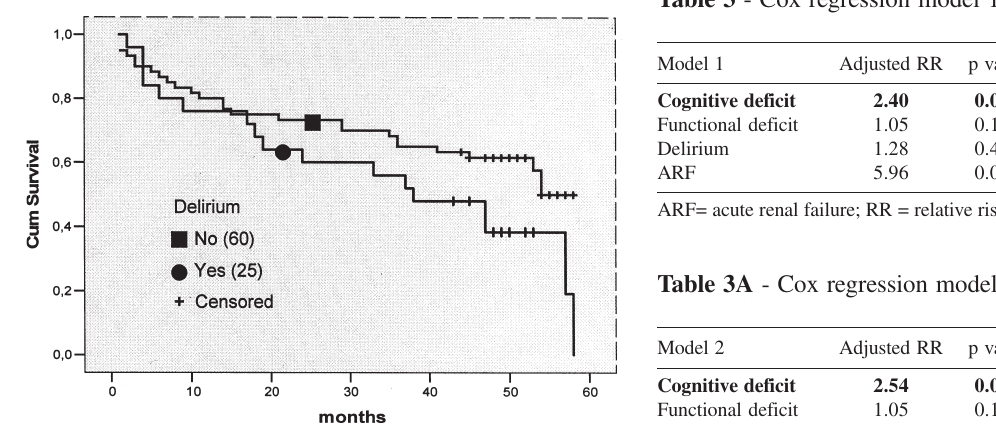
Figure 1 - Kaplan-Meyer survival curves for patients or without delirium. No significant difference occurs between the 2 groups.